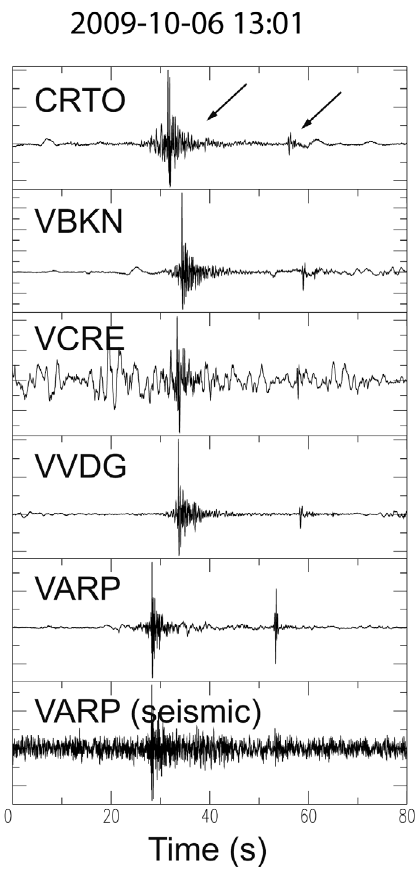
Figure 13. Infrasonic (top 5 traces) and seismic (bottom) signals of an event of unknown origin recorded on Vesuvius at 13:01 UTC on October 6, 2009. The arrows indicate two distinct phases in the in- frasonic